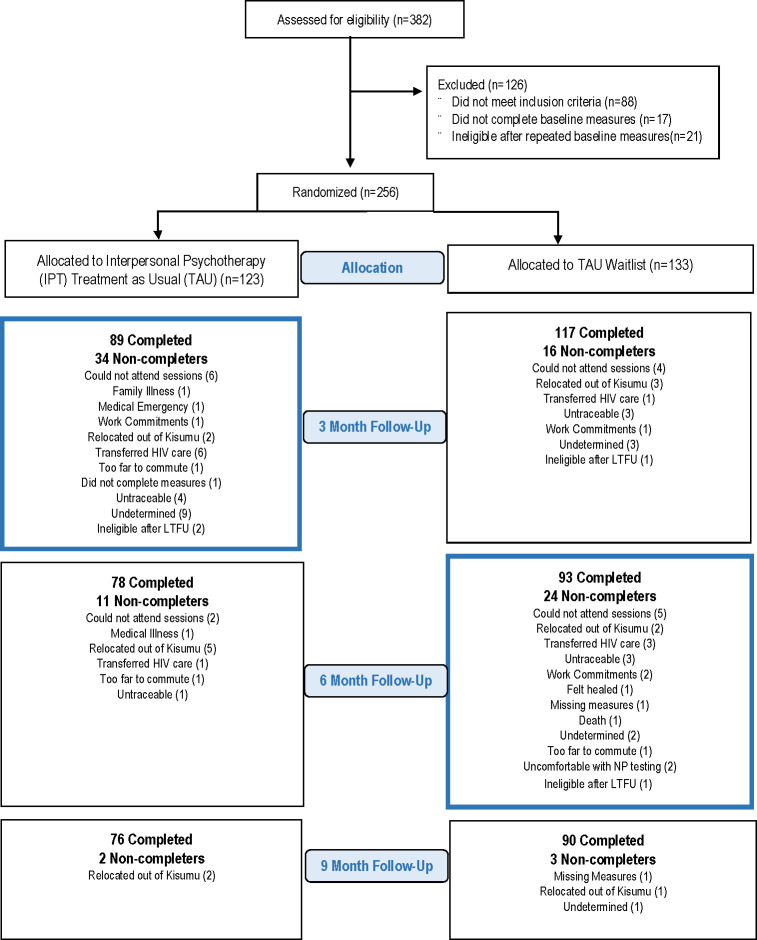
Participant flow.